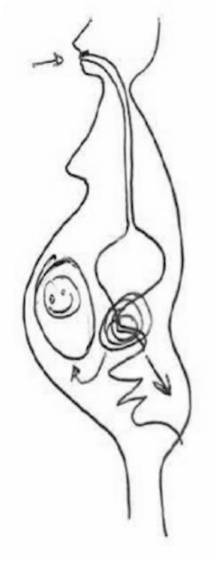
Figure 7. Pregnant, secondary education, employed in marketing